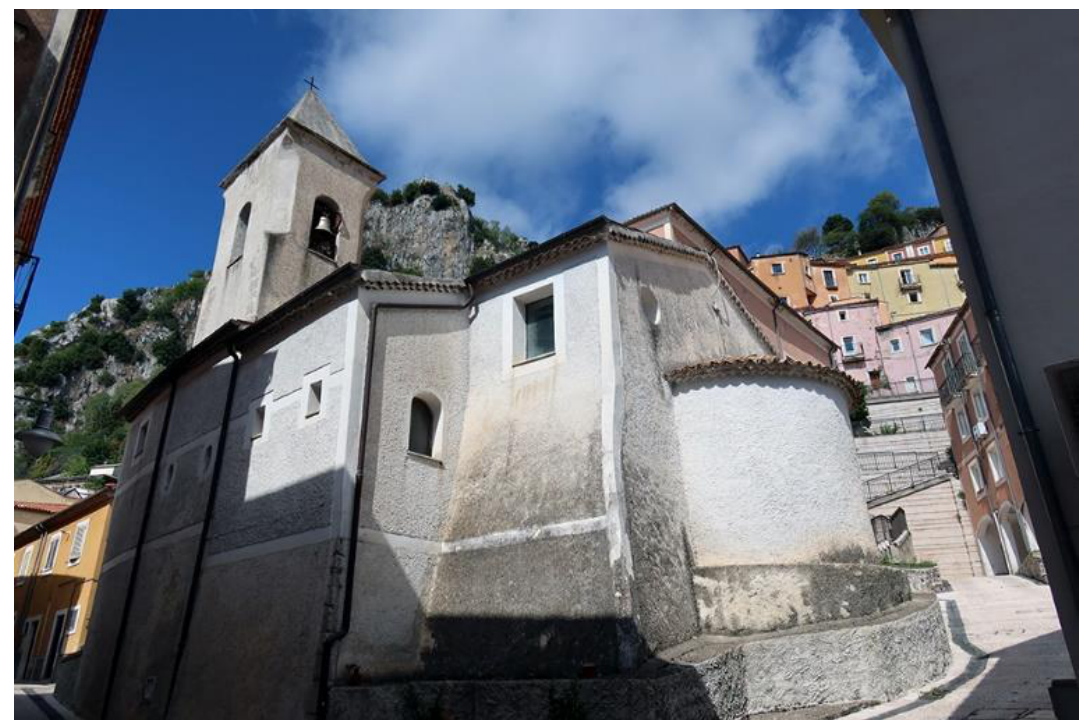
Geosciences 2021 , 11 , x FOR PEER REVIEW Figure 84. Colliano: detail of the restored historical centre (Church of Santa Maria del Borgo) (photos by [35,36]).